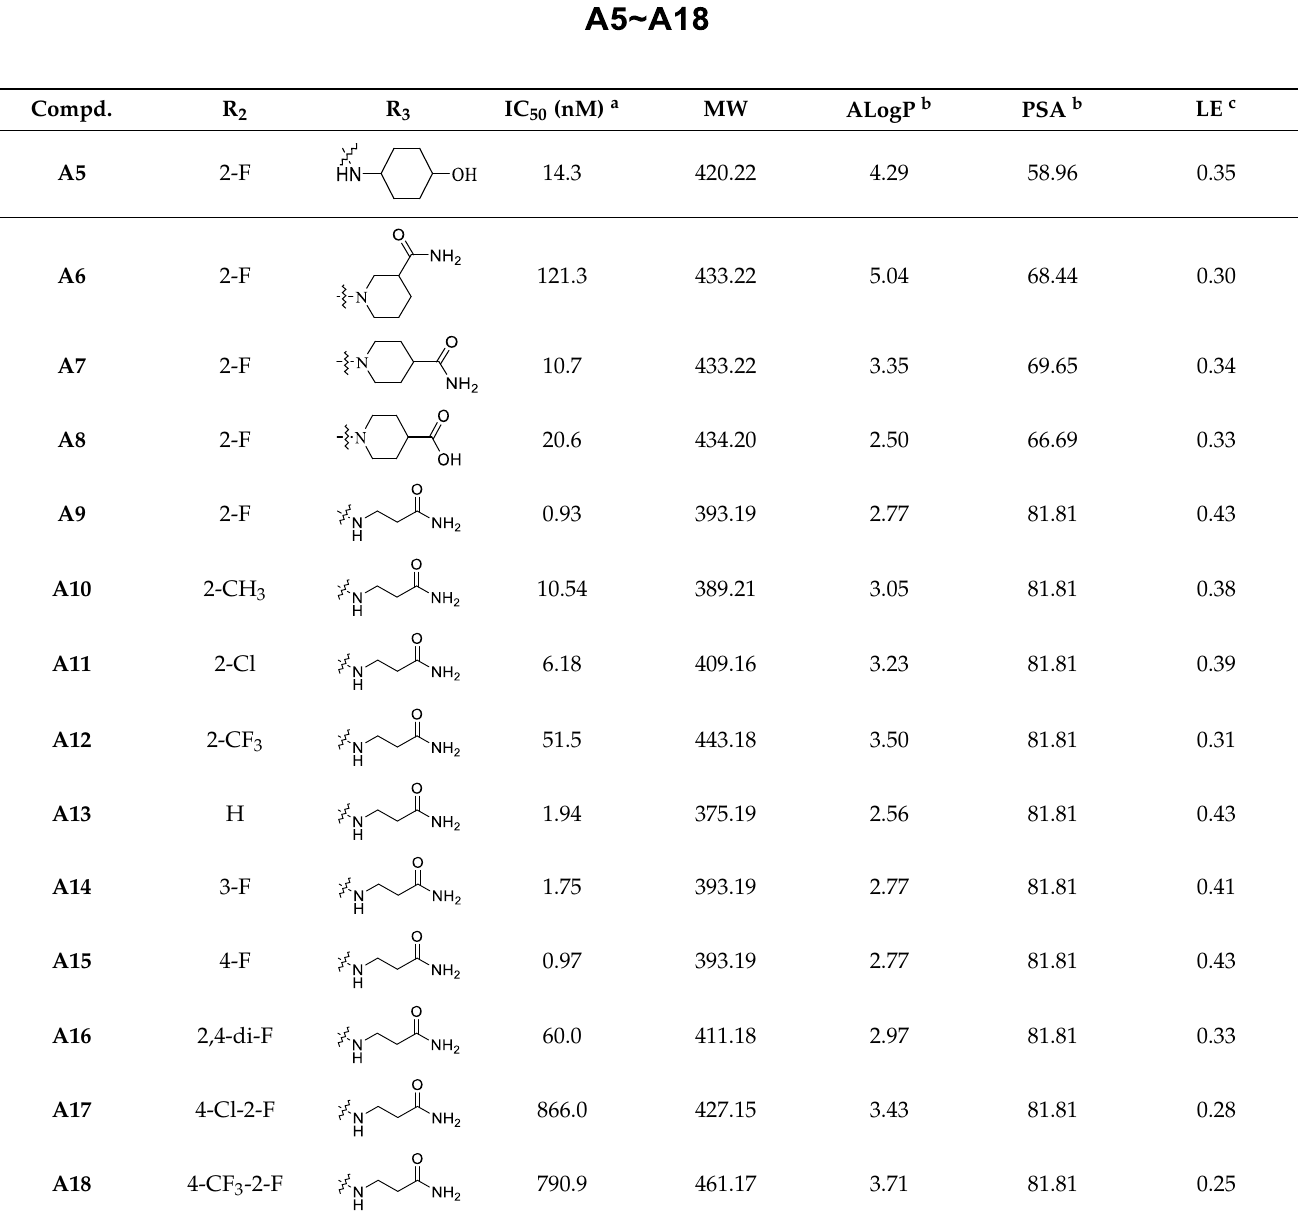
activity relationships (SARs). The replacement of 2-fluoro by the bulkier 2-methyl ( A10 , IC 50 = 10.54 nM) or 2-trifluoromethyl group ( A12 , IC 50 = 51.5 nM) leads to a decrease in the activity of more than 10-fold as compared with A9 . The chloro substituted compound ( A11 , IC 50 = 6.18 nM) exhibited slightly higher inhibitory activity compared to A10 . As expected, the unsubstituted phenyl ring A13 ( A13 , IC 50 = 1.94 nM) yields an approximately